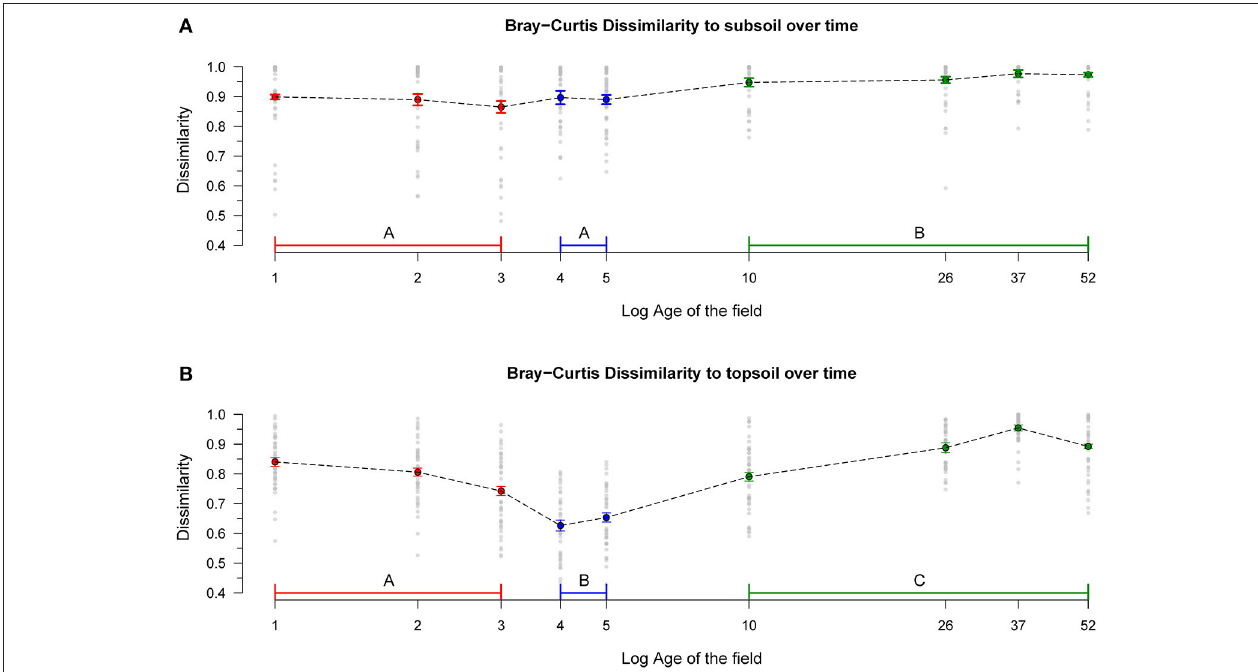
FIGURE 3 | Dissimilarities to Sub- and Topsoil over time. Bray-Curtis distances (i.e., dissimilarities in both community composition and relative abundances) between chronosequence fields and (A) subsoil communities and (B) topsoil communities. Dotted lines link the means, bars represent the standard error. Different phases are coded by color, significant differences between phases are represented by different letters. Details on the statistics are presented in Table S2. Phase 1: 1–3 years, n = 135. Phase 2: 4–5 year, n = 90. Phase 3: 10–52 years, n =